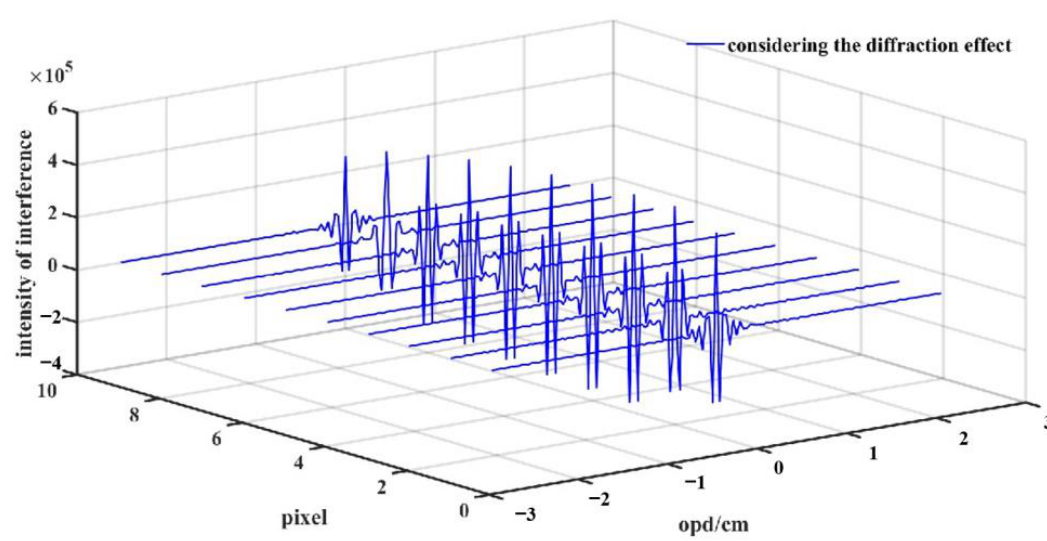
Figure 9. Interferogram considering the diffraction effect.